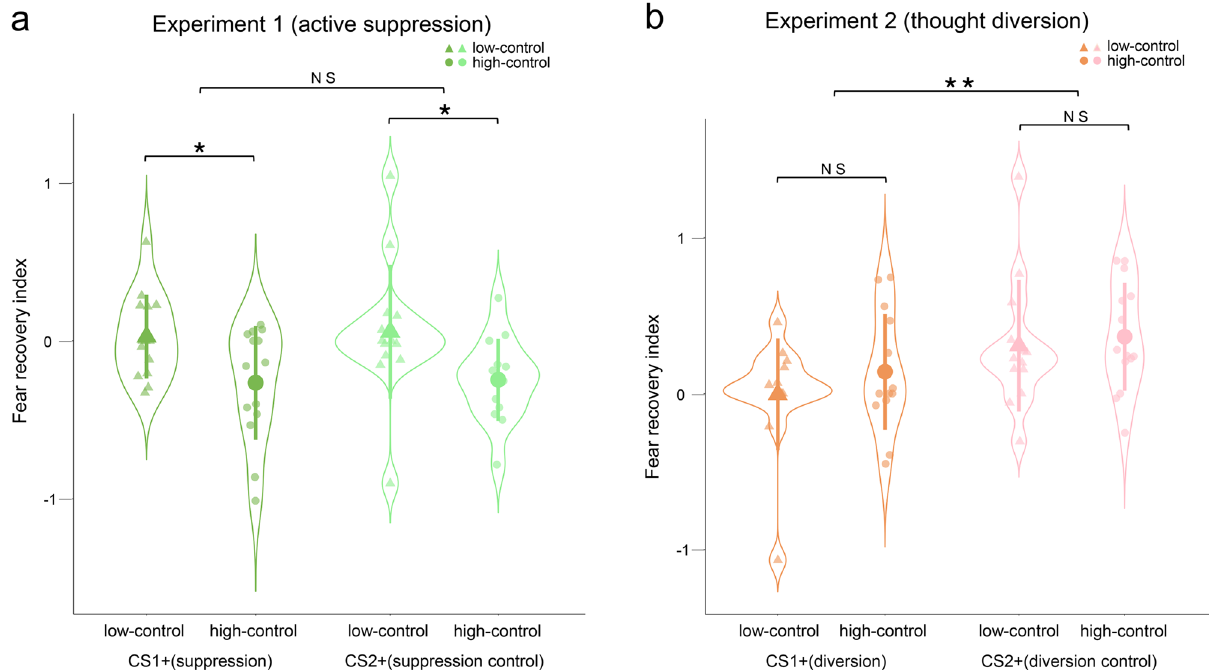
Fig. 3 Fear recovery as a function of thought-control abilities. a After direct active suppression manipulation, high thought-control participants showed less fear recovery than low-control participants for both CS. b Thought diversion only diminished the CS-speci fi c fear response, and thought-control ability was not associated with the fear recovery of CS + . For both experiments, means of fear recovery index are depicted as large circles for high-control subjects and triangles for low-control participants. Standard deviations are depicted in bars, measures for each subject in small dots and triangles, and distribution in violin shape. * P < 0.05, ** P < 0.001. NS non-signi fi